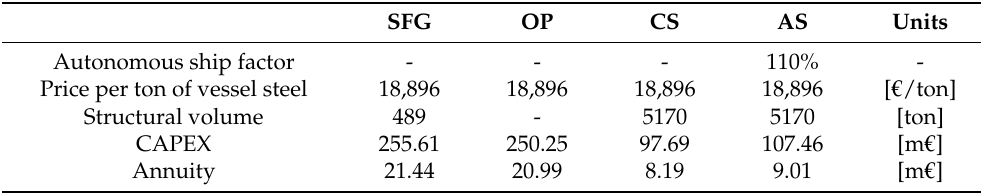
Table A8. Results for CAPEX calculations for average values. Scenario: 2.5 mtpa and 180 km. SFG OP CS